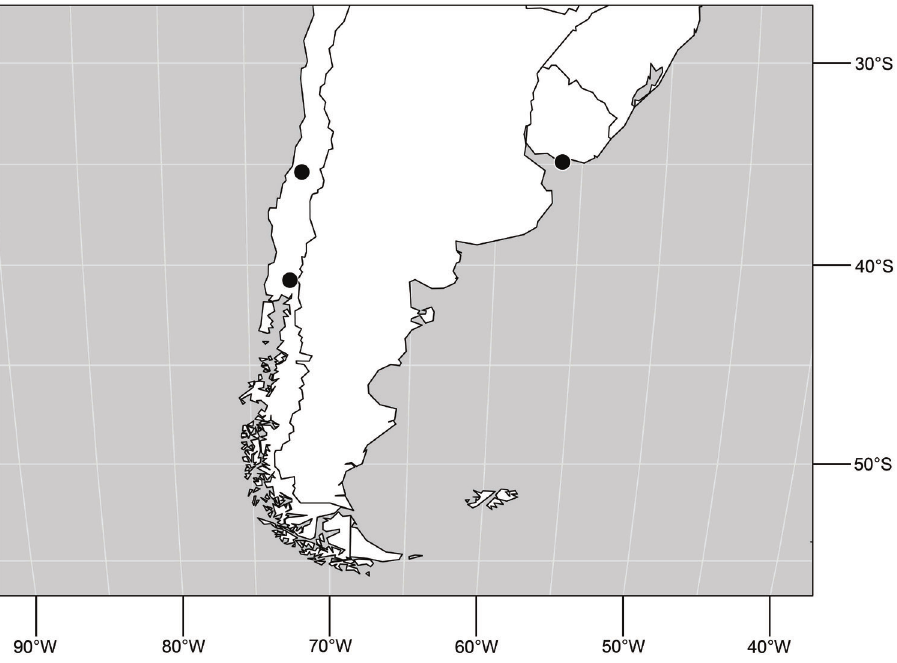
Figure 30. Distribution of Hydrochasma patens Cresson